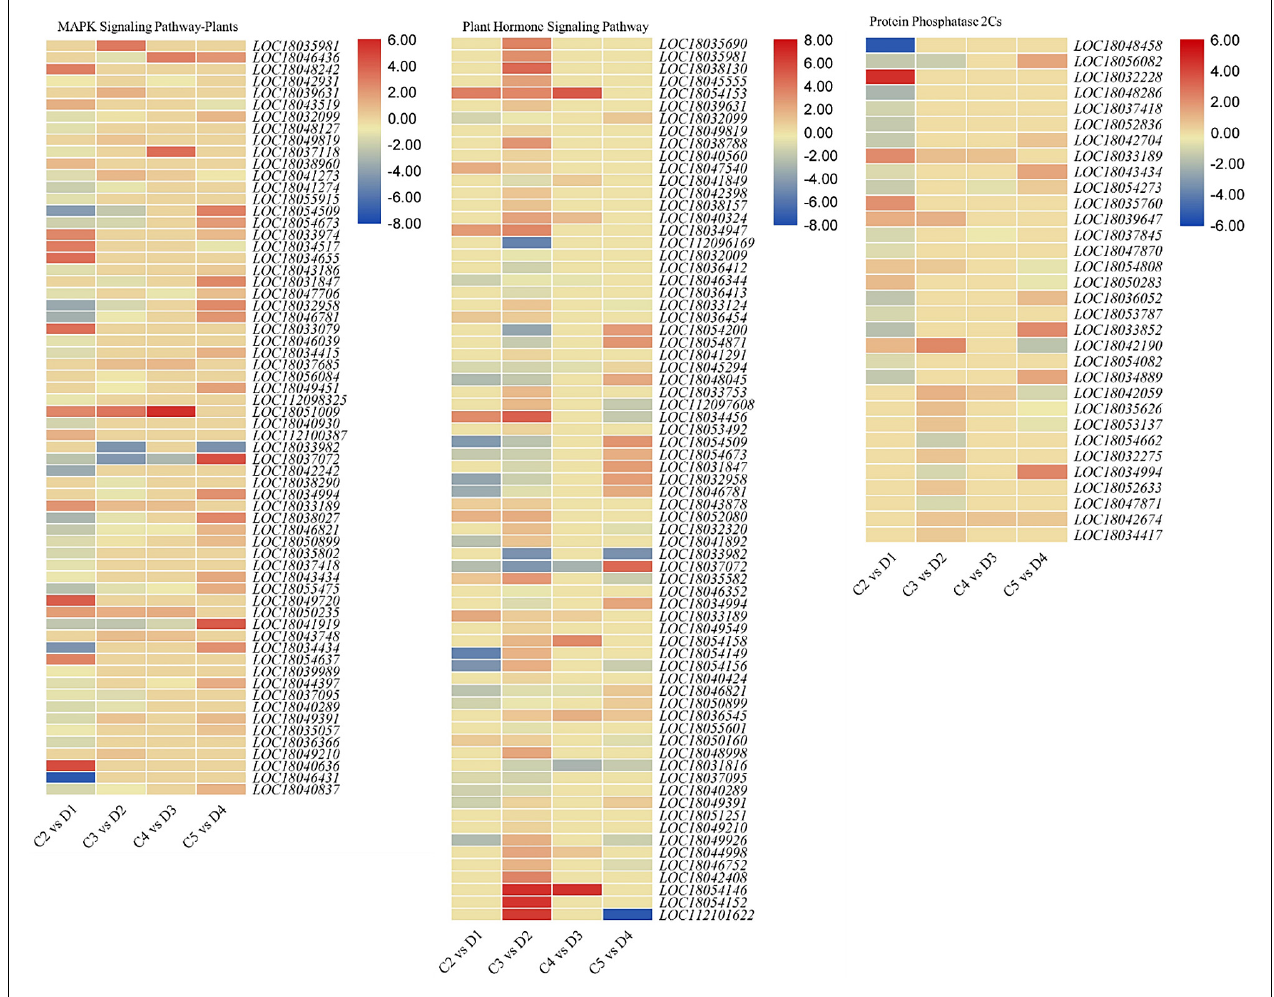
FIGURE 3 | Heatmaps of log2 FC of differentially expressed genes (DEGs) enriched in the MAPK and plant hormone signaling pathways in treatment comparisons between C and D of C. limon. C2, C3, C4, and C5 represent samples collected 60, 90, 120, and 150 days after flowering. D1, D2, D3, and D4 represent samples collected 60, 90, 120, and 150 days after flowering. The numbers 1, 2, and 3 with each treatment represent the three replicates. Gene IDs are consistent with the gene descriptions given in Supplementary Table 4